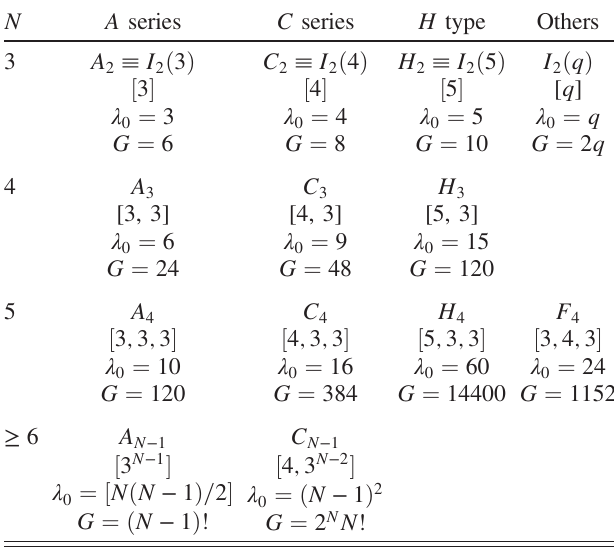
TABLE I. Connected, nonbranching, finite Coxeter reflection groups. For N particles, each rank m ¼ N − 1 Coxeter group defines a one-parameter family of masses for which the system is exactly solvable. For each group G , the following data are m provided [64]: the Coxeter bracket ½ q 1 ; … ; q from which one m (cid:3) determines the angles of the integrable sector; the number of reflections λ 0 in the group which determines the relative angular momentum of the ground-state solution; and the order G of the group which gives the number of integrable sectors required to tile the sphere. Note that there are two series of groups A and C m m that provide integrable mass families for any number of particles.